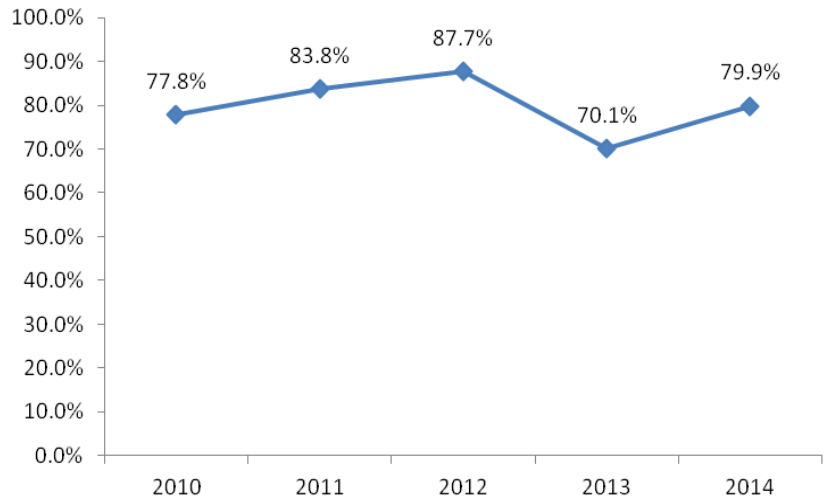
Figure 2. Variations of the annual excellent rate of air quality of Wuhan from 2010–2014.